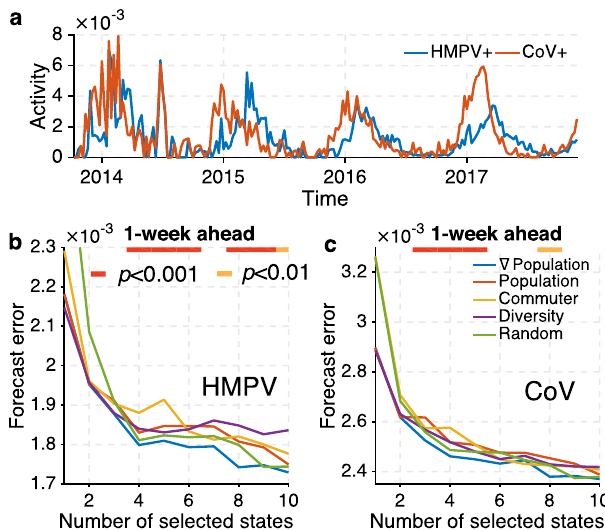
Fig. 5 Retrospective forecasts for human metapneumovirus (HMPV) and coronavirus (CoV). a The national HMPV + rate (blue line) and CoV + rate (red line) for the 2013 – 2014 to 2016 – 2017 seasons from AFHSB data. Forecast errors for 1-week ahead predictions of HMPV and CoV in 35 US states from 2013 to 2017 are reported in ( b ) and ( c ). We focus on surveillance networks consisting of less than 10 states because monitoring more states only provides nominal improvement. The horizontal bar on top indicates the statistical signi fi cance for ∇ Population (blue line) outperforming methods based on population (red line), number of commuters (orange line), diversity of commuters ’ residential locations (purple line), and random selection (green line) (two-sided Wilcoxon signed-rank test; red: p < 0.001, orange: p < 0.01, none: p ≥